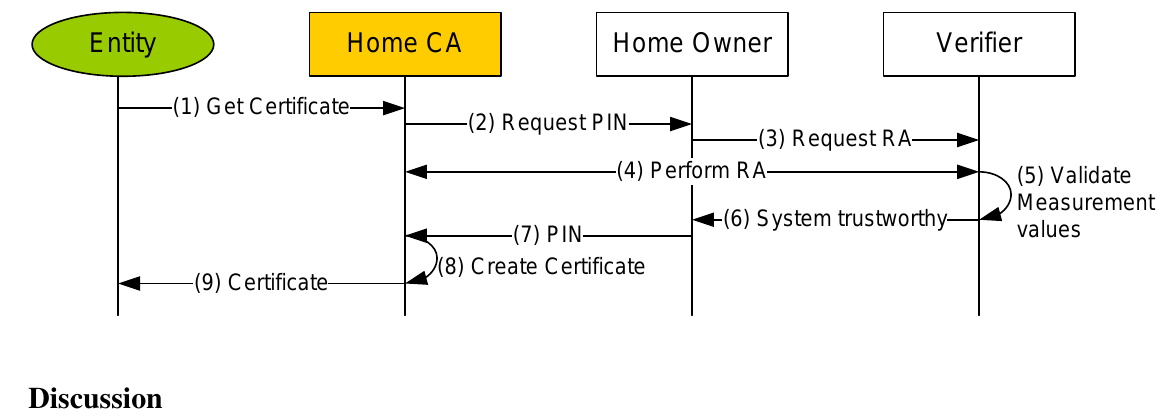
Figure 6. Remote Attestation of the Home CA. When a certificate needs to be created (1), the Home CA requests the home owner to enter the PIN (2). The owner triggers the RA process (3–5) and enters the PIN (7) if the Verifier assesses the Home CA as trustworthy (6). The Home CA now is able to unlock the HK and create and deliver the certificate (8 +